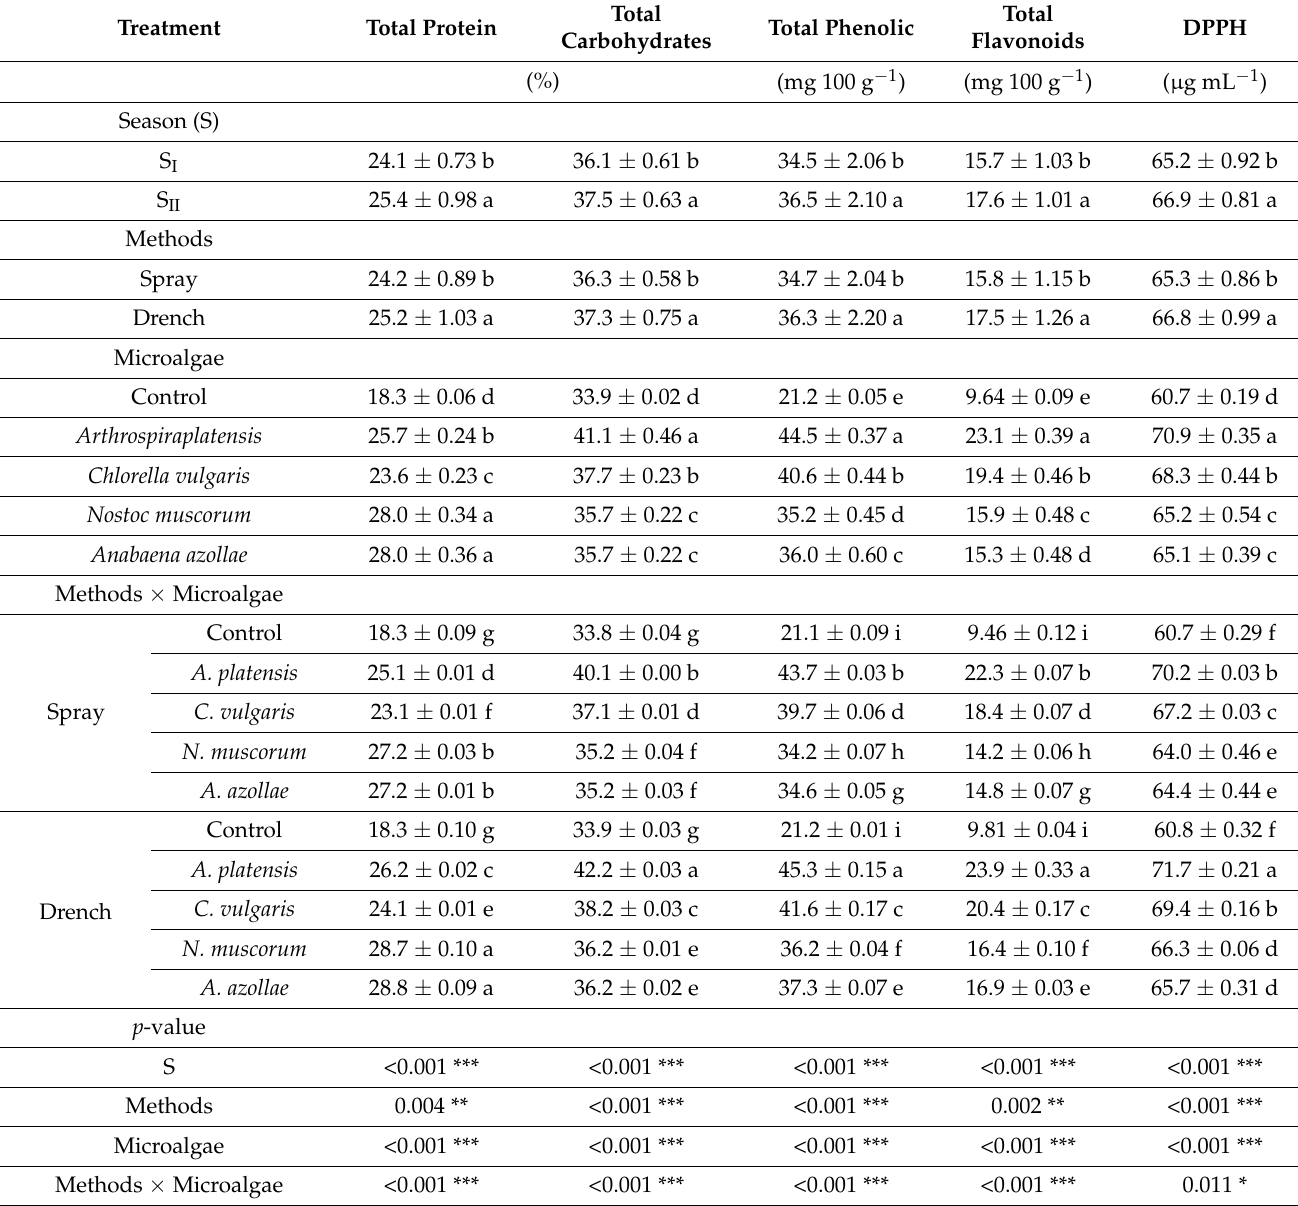
Table 5. Total protein, total carbohydrate, total phenolic, total flavonoid, and DPPH levels in chia seeds cultivated under alkaline stress conditions in response to different application methods, microalgae strains, and their